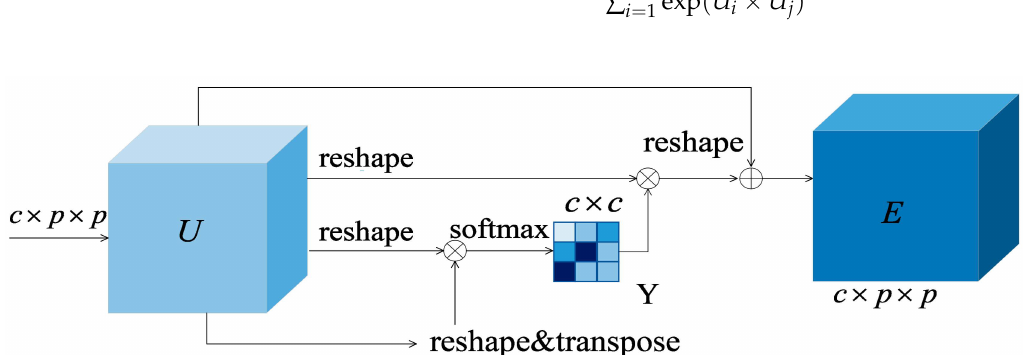
Figure 5. The schematic diagram of spectral attention